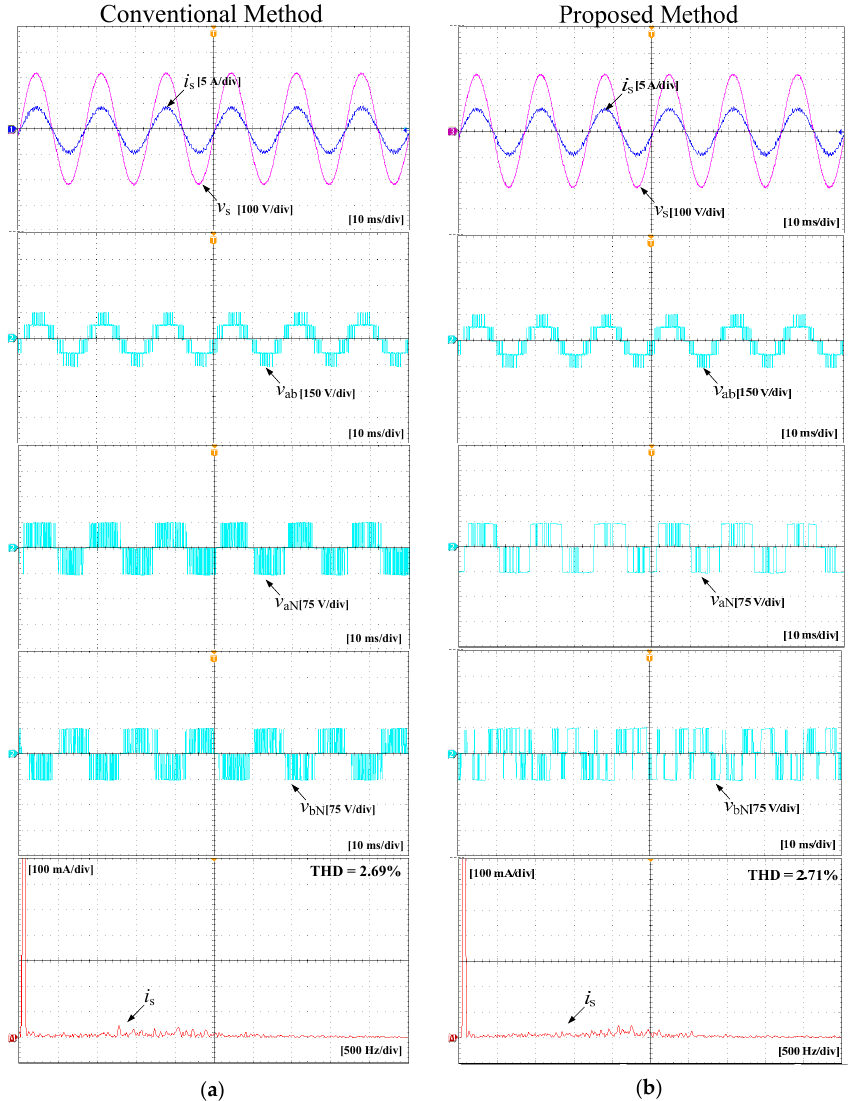
Figure 20. Experimental results of ac source current ( i s ) and source voltage ( v s ), converter input voltage ( v ab ), pole voltage ( v aN , v bN ), and FFT analysis of source current ( i s ) in ( a ) conventional and ( b ) proposed methods.